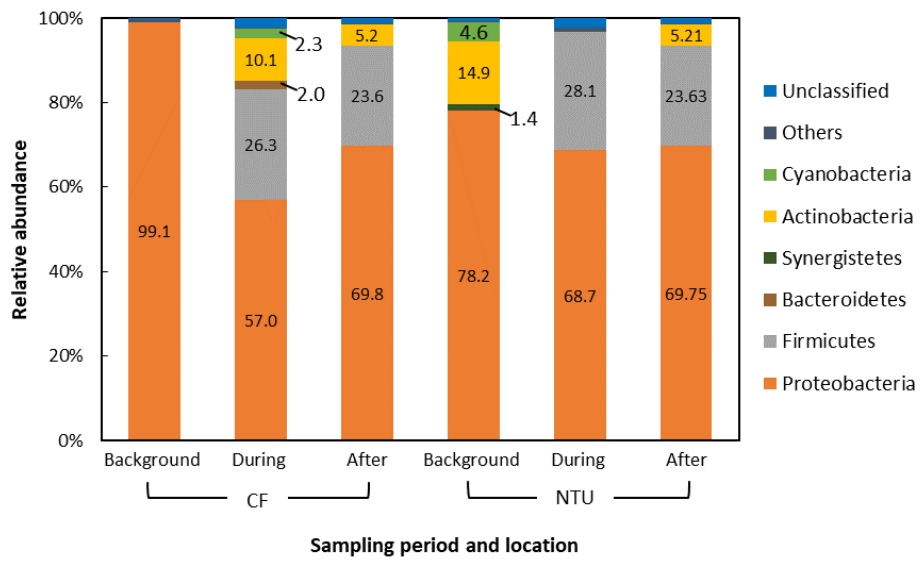
Figure 5. Compositions of the bacterial community at phylum taxon for the Asian dust storm. The phyla with the relative abundance of less than 1% were not listed.